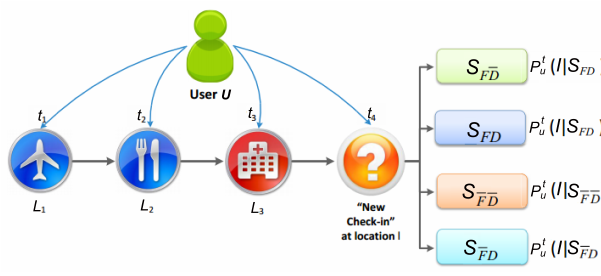
Fig. 14 Influence of new check-in behaviour on geo-social correlation [59]